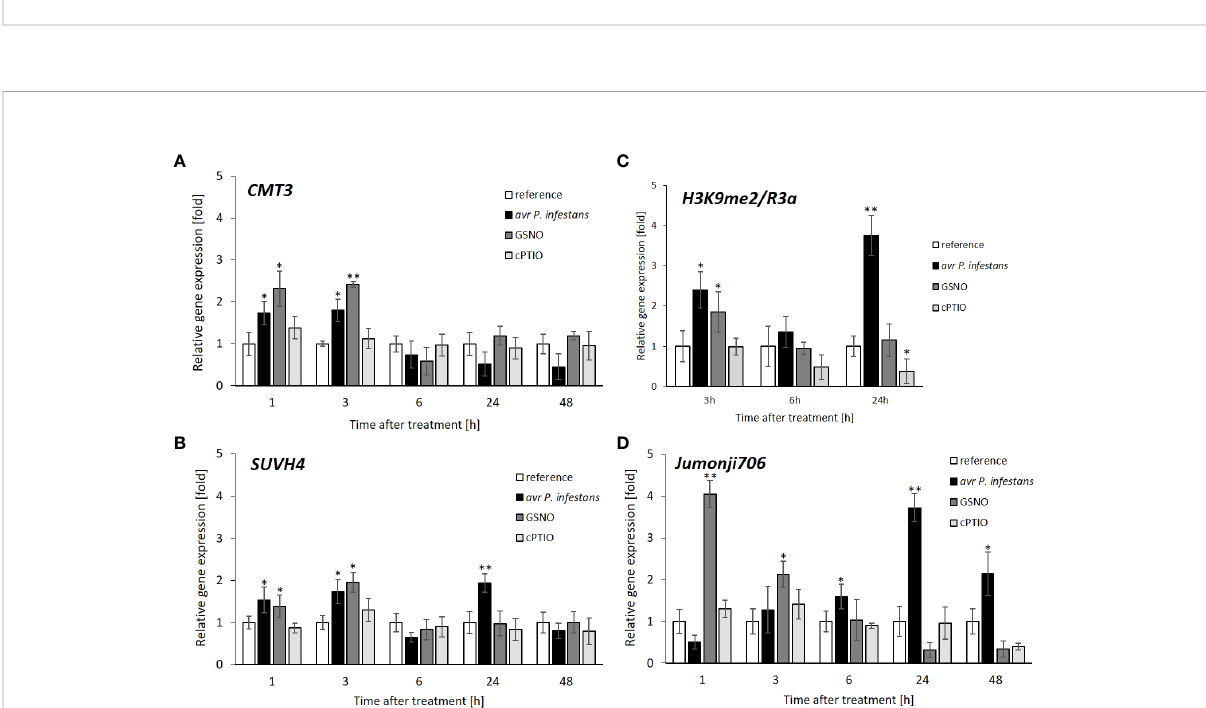
FIGURE 3 Functional link between histone and DNA methylation due to potato leaves treatment with pathogen or GSNO. CMT3 DNA methyltransferase expression pro fi le (A) , SUVH4 histone methyltransferase expression pro fi le (B) , distribution levels of SUVH4/mediated H3K9me2 on the promoter sequence of R3a (C) , JMJ706 histone demethylase expression pro fi le (D) . RT-qPCR gene expression of CMT3 , SUVH4 , and JMJ706 was analyzed in potato leaves (at 1-48 h) after treatment with GSNO, cPTIO, water, or avr P . infestans inoculation, respectively. ChIP-qPCR analyses were performed in potato leaves at selected time points (3-24 h) after treatment with GSNO, cPTIO, water, or avr P . infestans inoculation. Data are presented as X-fold enrichment (Komar et al., 2016). The relative amount of immunoprecipitated chromatin fragments (as determined by real-time PCR) from the above treatment variants were compared with the reference (arbitrarily set to 1). There were no signi fi cant changes in the absolute values of the analyzed transcript levels after the leaves spraying with water. Each experiment included at least three independent measurements per sample. P values for each sample combination were calculated using ANOVA, and mean values were compared using the Tukey-Kramer test ( a =0.05 ( ∗ ) and a =0.01 ( ∗∗